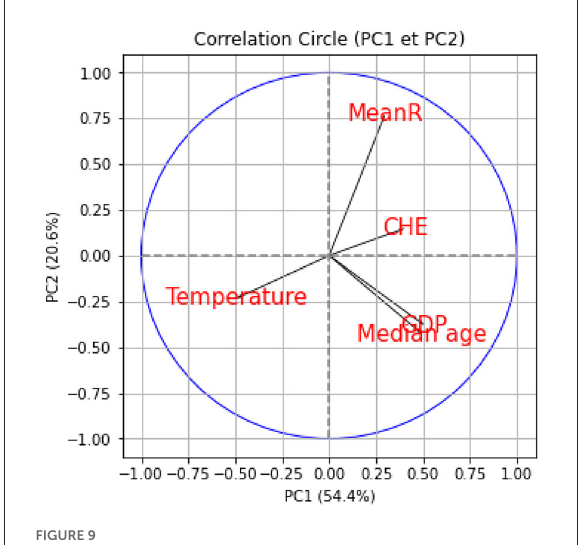
FIGURE9 Correlation circles for the two first PC planes.